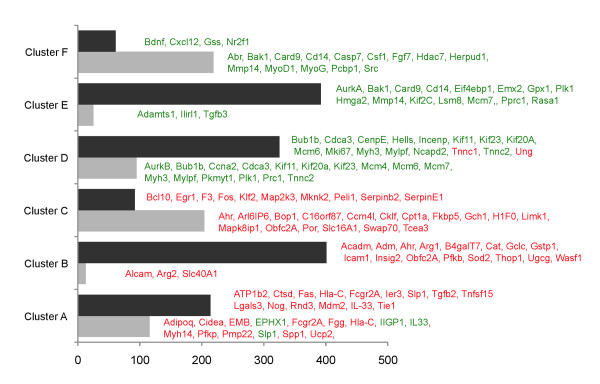
H9c2 cardiac myocytes elicit unique gene expression in response to TSA or CBHA at 6h. A vast majority of genes in clusters A, B and C was up regulated (red) by TSA and CBHA while the expression of genes in clusters D, E, and F was suppressed (green) by both HDACIs.